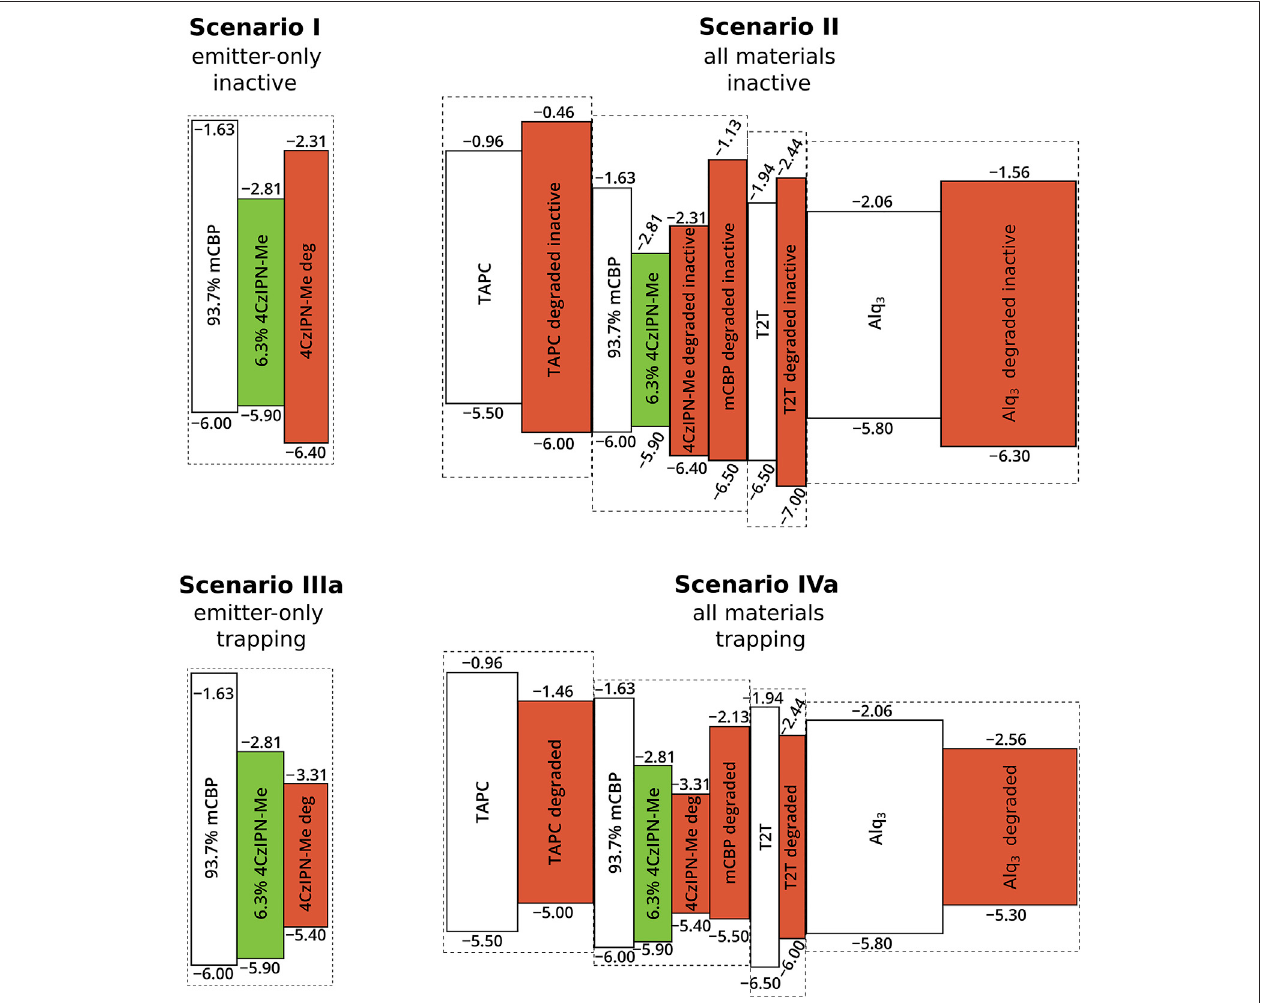
FIGURE 6 | Overview of the simulated degradation product scenarios I, II, IIIa and IVa. The undegraded materials are shown in white (green for the emitter) and degradation products are red. In scenariosI and II, the degradation process results in asymmetric increase by 1 eV of the HOMO – LUMO gap of thedegrading material, whilescenariosIIIaandIValeadtoasymmetric decrease ofthatgapby1 eV.InscenariosIIIbandIVb(notshown),degradationleadstoasymmetricdecreaseofthegap by 2 eV. In scenarios I and III, only degradation the TADF emitter material 4CzIPN-Me is considered, while in scenarios II and IV all materials in the stack can